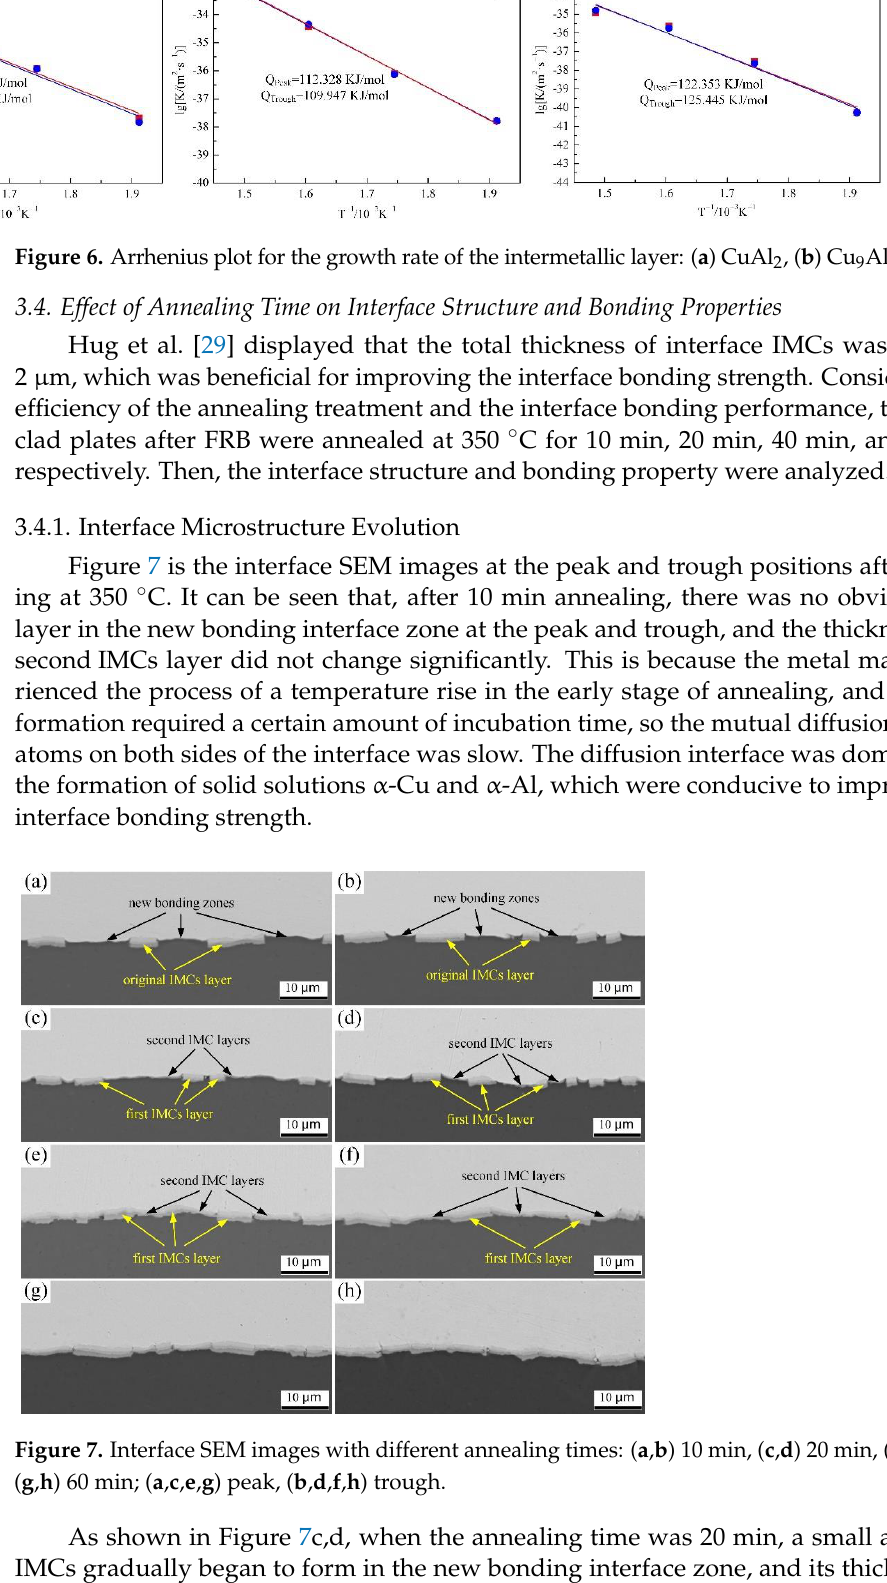
2 , ( b ) Cu 9 Al 4 , ( c ) CuAl.